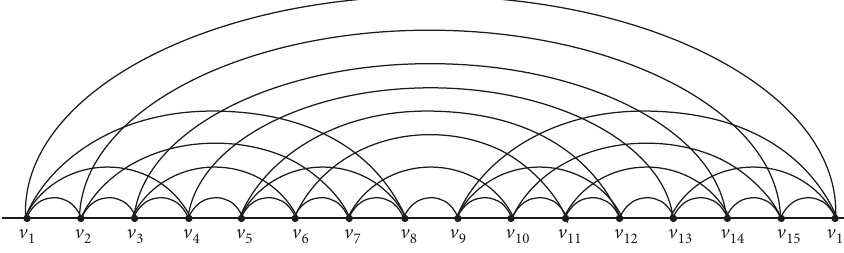
Figure 4: The 2-page drawing of 𝑄 4 with fixed vertex